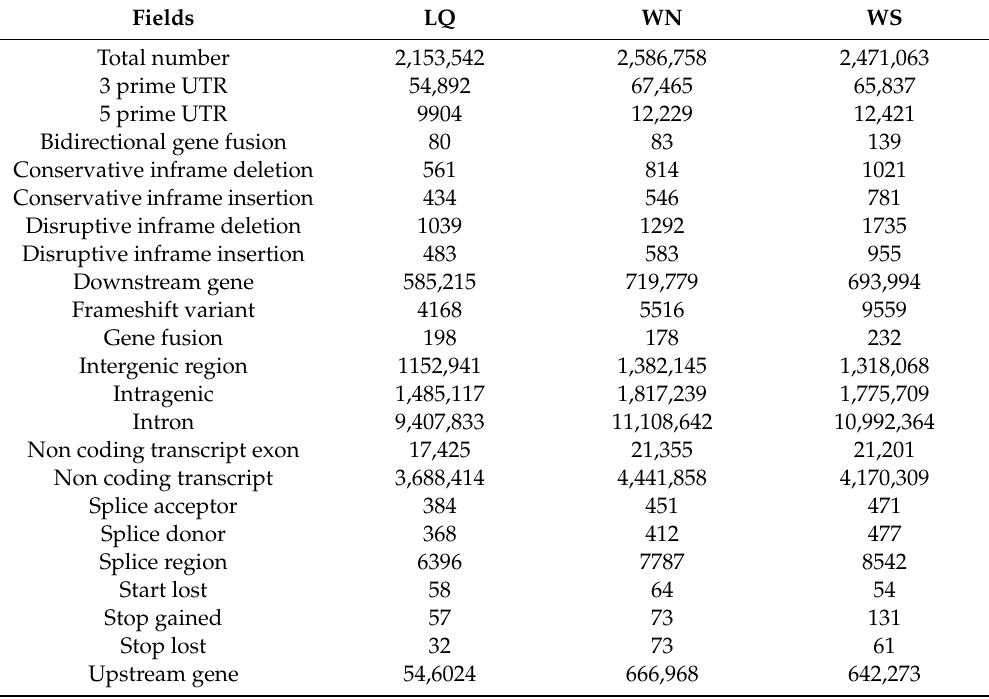
Table 3. Distribution of SnpE ff annotation InDel variants in three cattle breeds.